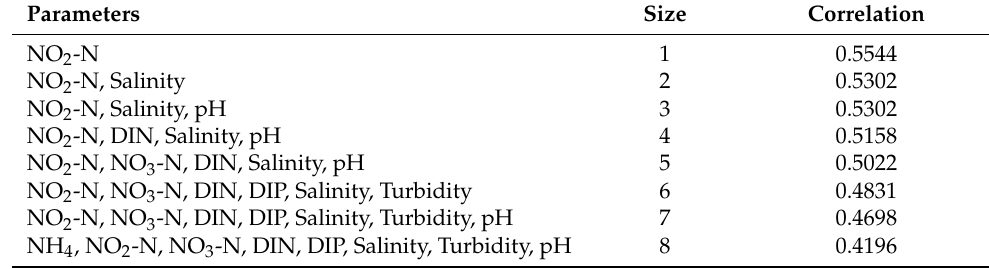
Table 6. Results from the BIO-ENV procedure showing the best overall combination of environmental parameters in the waters around Macau examined in December 2019.